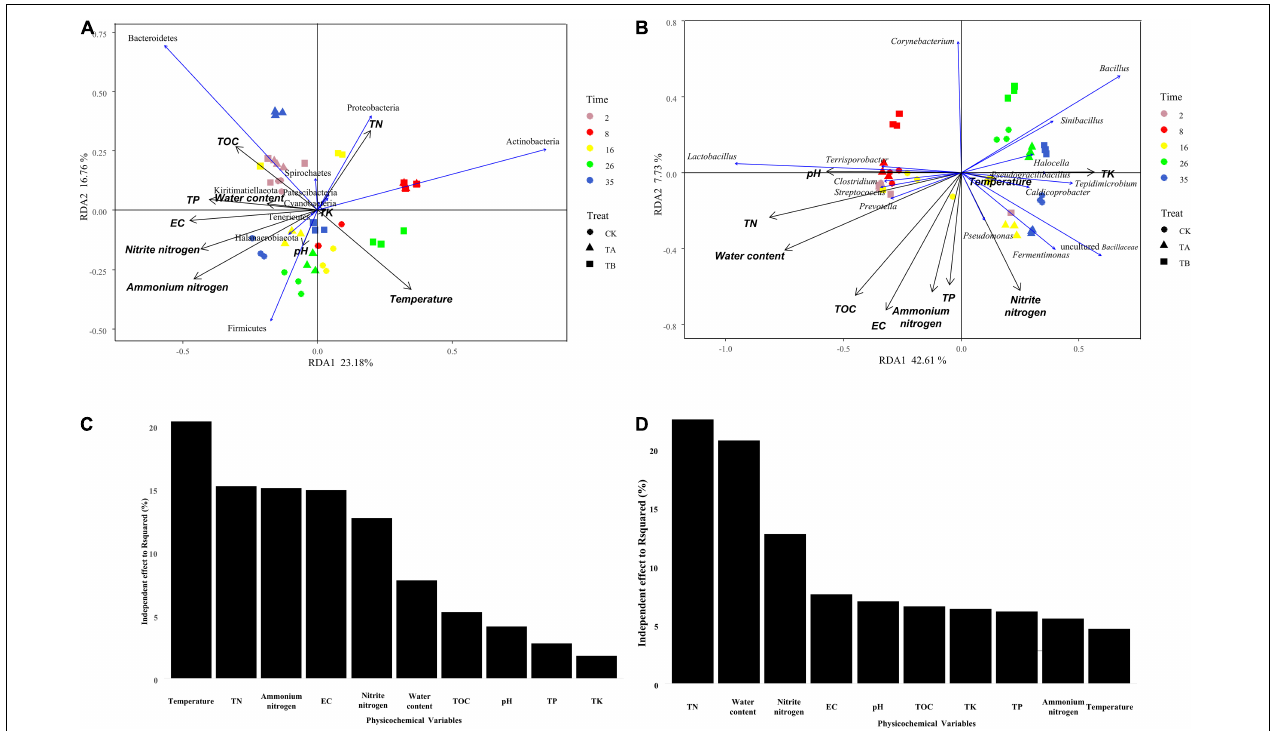
FIGURE 8 | Bi-plot from the redundancy analysis (RDA) showing the relationships between phylum-level (A) and genus-level (B) of bacterial community compositions and physicochemical variables for all samples. Independent effect of physicochemical variables on bacterial community composition at the phylum level (C) and genus level (D)